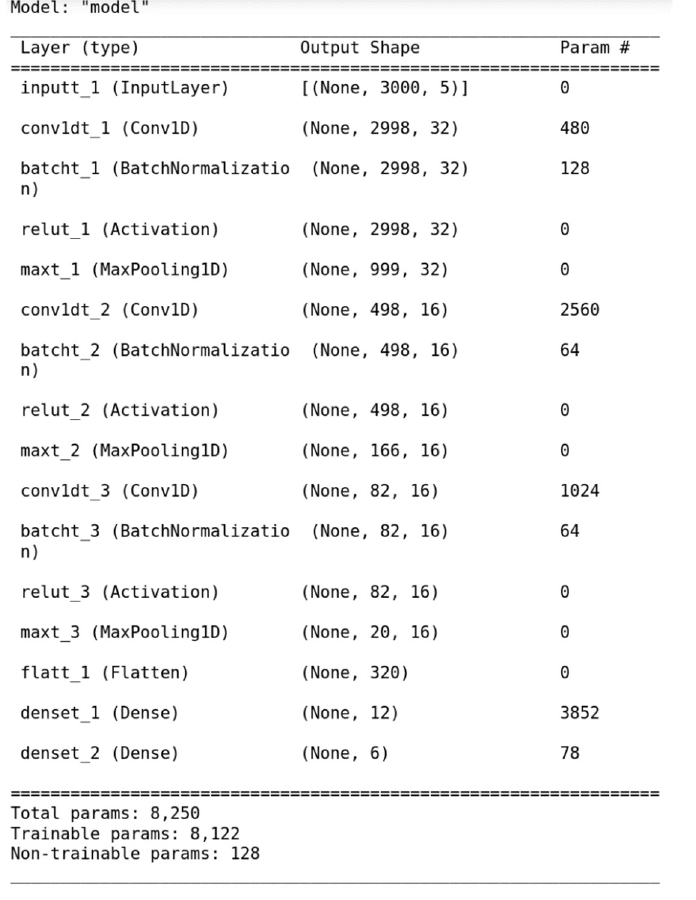
Figure 5. Structure and parameters for an artificial intelligence network.